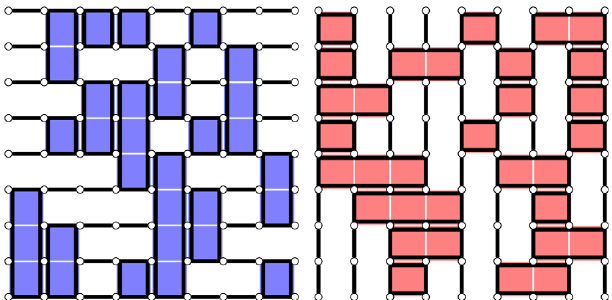
FIG. 1. An example of a compass code on a 9 × 9 lattice with qubits placed on vertices. Red and blue plaquettes represent cuts in the Z -type and X -type stabilizers, respectively. Equivalently, Z -type stabilizers are formed by blue plaquettes on the left, and X -type stabilizers are formed by red plaquettes on the right. Bare horizontal lines on the left represent horizontal ZZ stabilizers or “ 0 ” -area blue plaquettes; the analogous vertical lines on the right form XX stabilizers. As there are no blank plaquettes in the combined picture, all of the gauge d.o.f. are